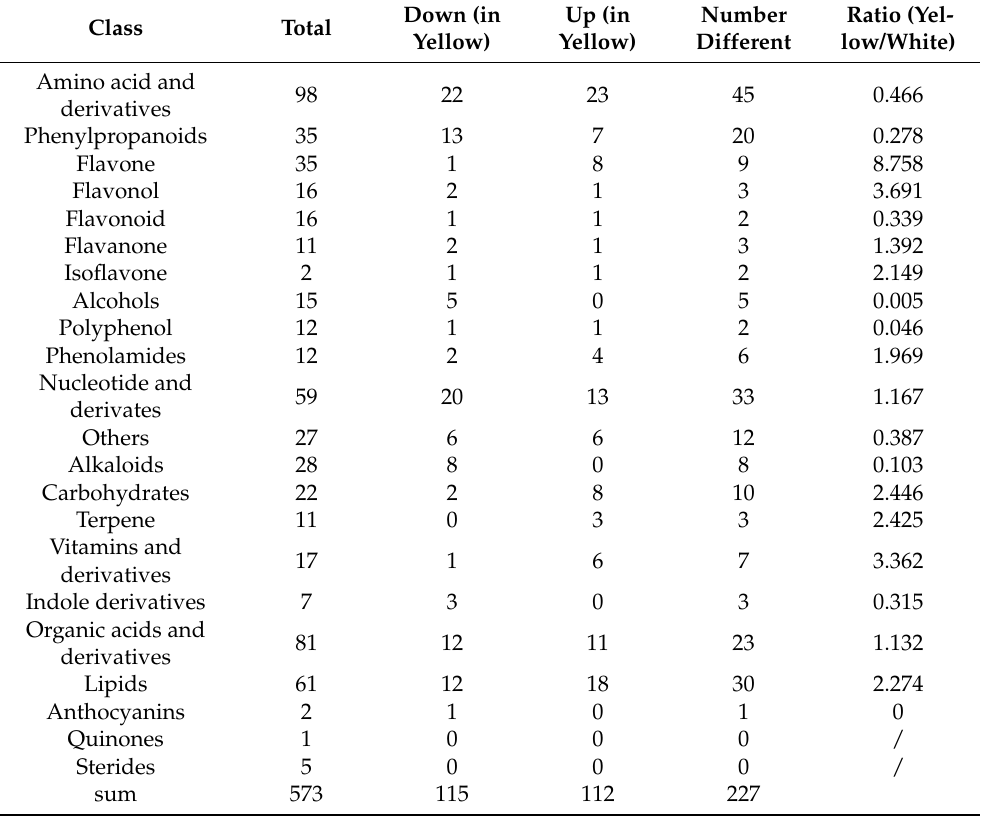
Table 1. Summary of differently accumulation chemical compounds in yellow and white